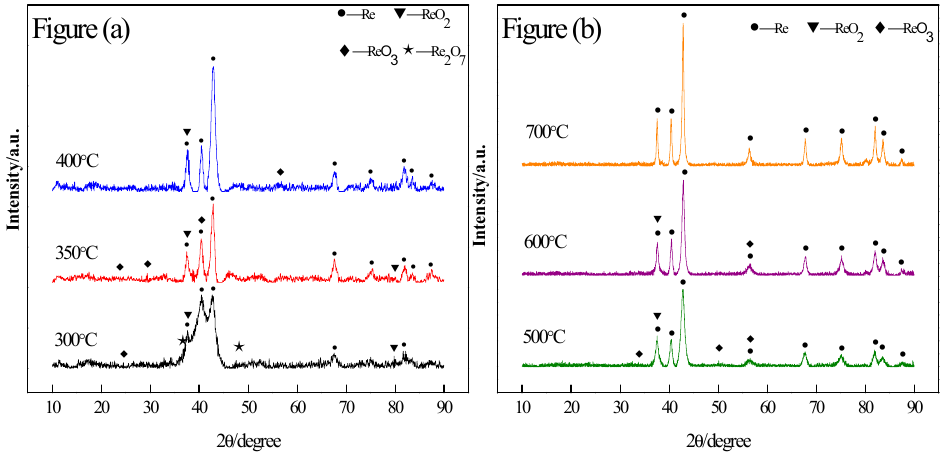
Figure 5. XRD patterns of the reduction products of ammonium perrhenate (D 50 was 71.17 µ m, specific surface was 26.93 m 2 /kg) at different temperatures. Figure ( a ) was the XRD diffraction pattern of the reduced product at 300 to 400 °C; Figure ( b ) was the XRD diffraction pattern of the reduced product at 500 to 700 °C.